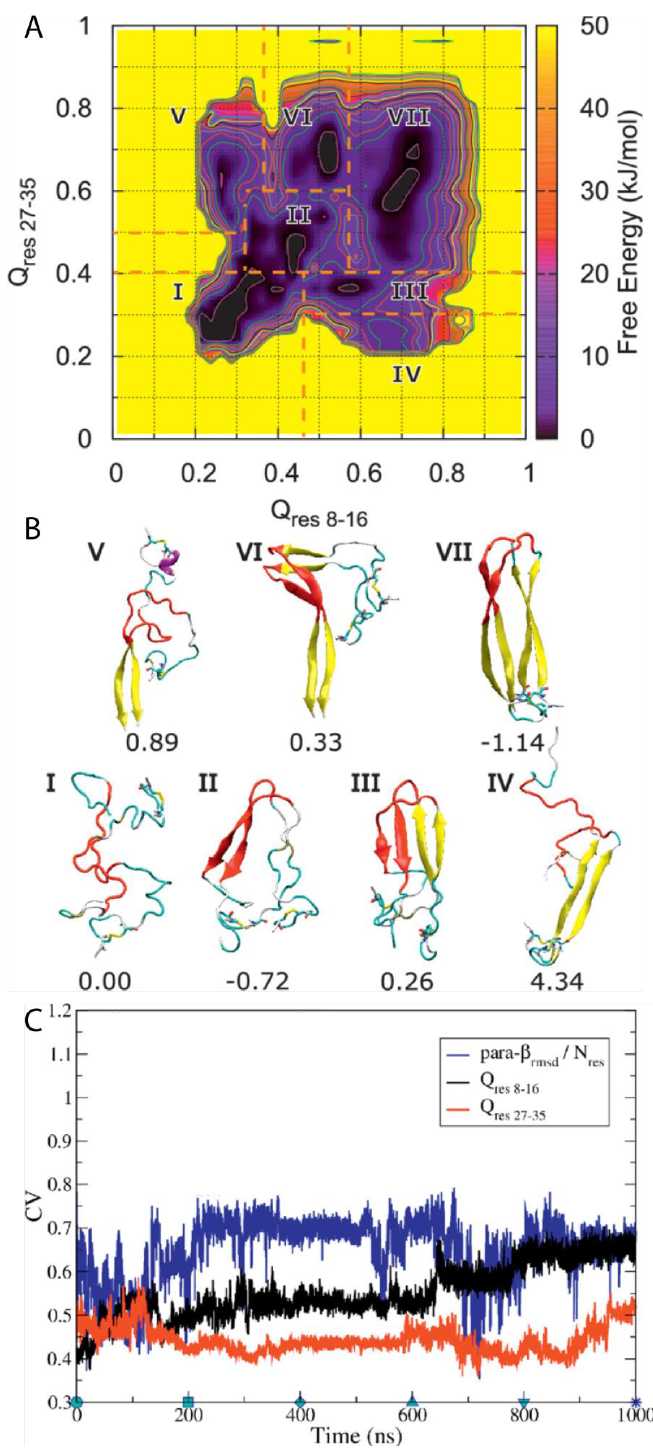
Figure 15. Characterisation of the dimerisation of hIAPP. ( A ) Progression of collective variables (CVs) with respect to simulation time. The inset is the free energy landscape of the system. ( B ). Representative structures from each free energy minimum. ( C ). Time evolution of Q res 8–16 , Q res 27–35 , and parallel β -RMSD. Adapted from Chiu and de Pablo [100]. Licensed under a Creative Commons Attribution (CC BY)